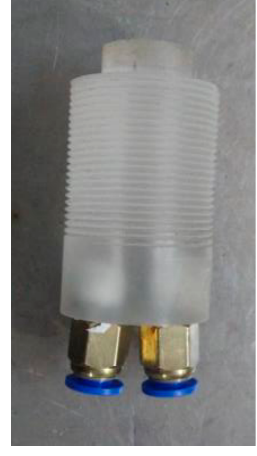
Figure 2. Experimental device and system: (1) water tank; (2) bubble generation module; (3) LED plane light source; (4) check valve; (5) float flow meter; (6) air pump; (7) high-speed camera; (8) computer.